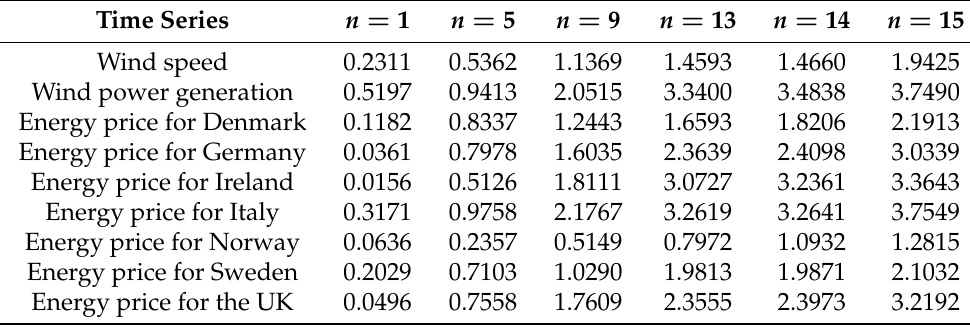
Figure 15. Error histogram for forecasting in each time series. Table 3. MAPE for time series forecasting for n -step-ahead